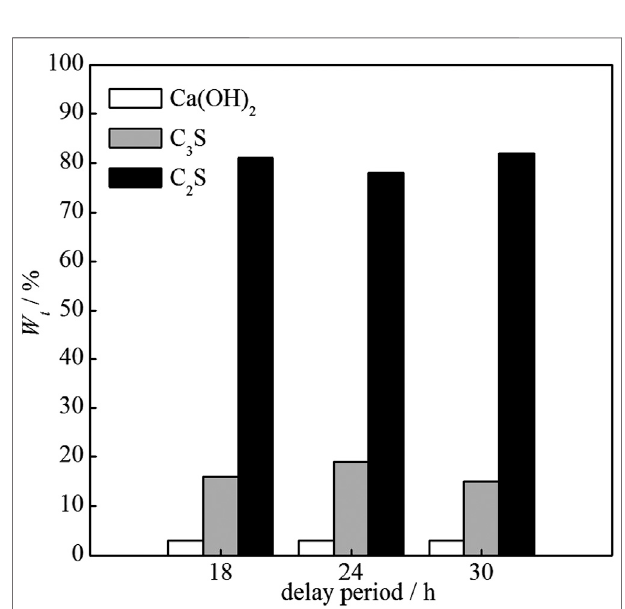
Figure 8 | XRD pattern of the paste sample under different delay period. (A) delay period 18 h. (B) delay period 24 h. (C) delay period 30 h.